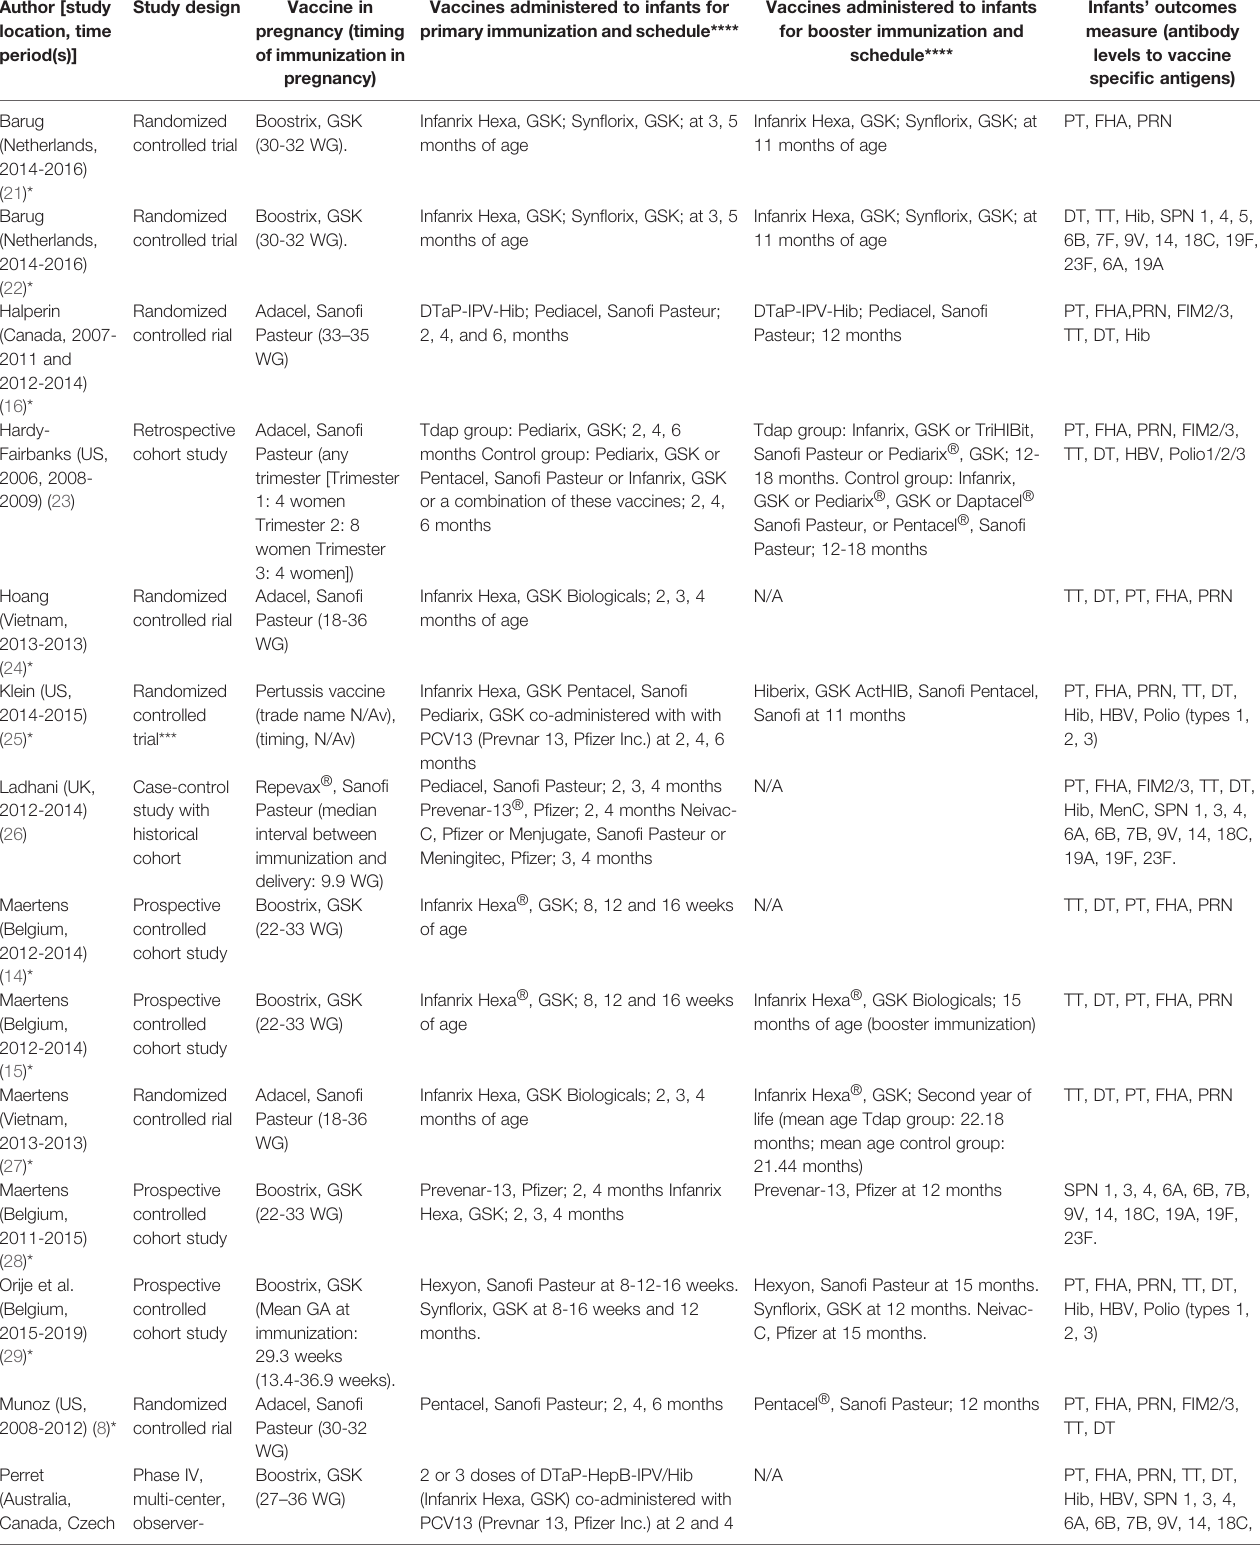
TABLE 1 | Characteristics of studies identi fi ed through the systematic